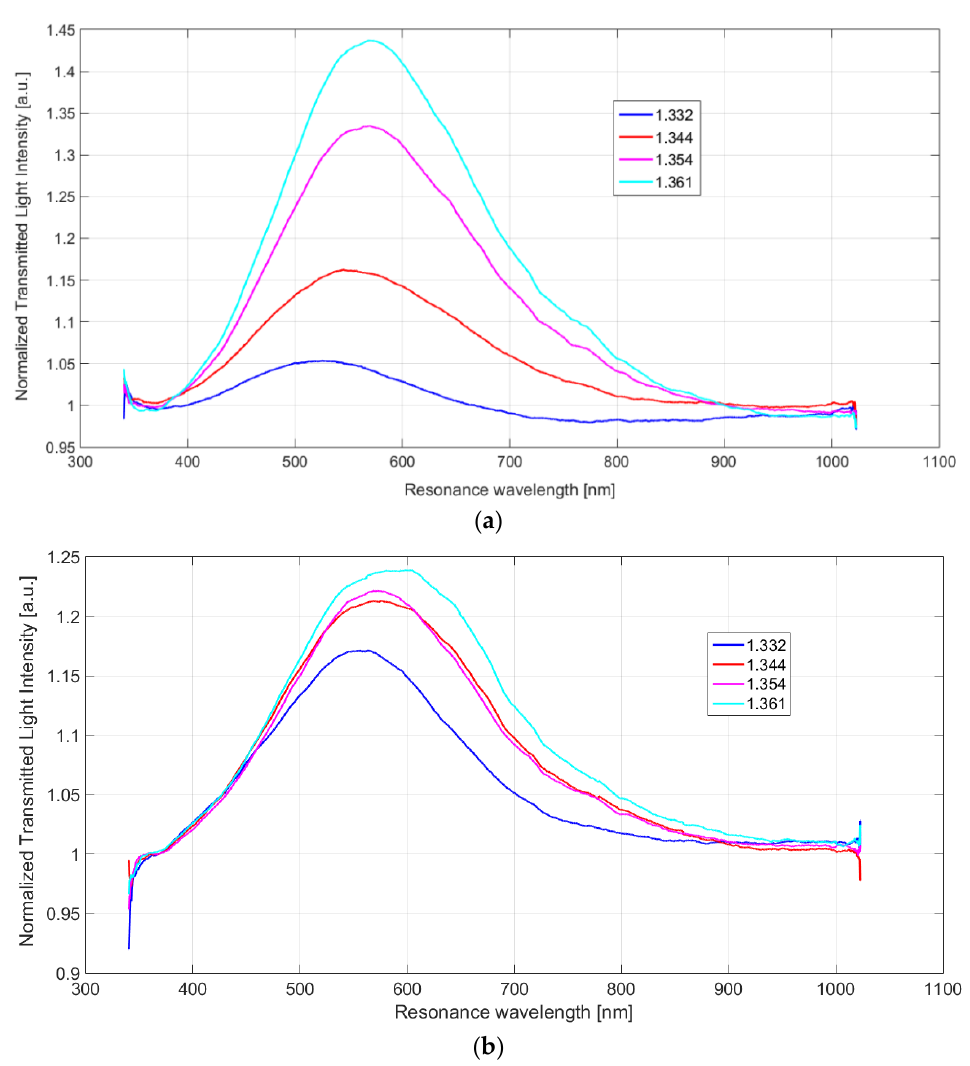
Figure 3. LSPR spectra obtained by two green plasmonic sensor configurations: ( a ) Sensor configuration without ILs in the BC layer. ( b ) Sensor configuration with ILs in the BC layer.